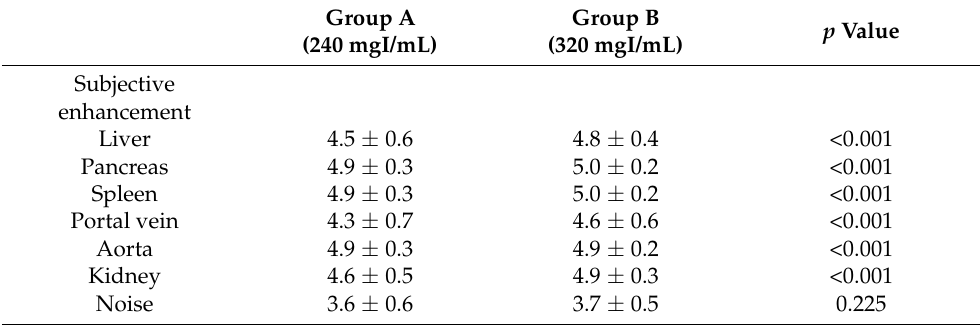
Table 4. Qualitative analysis in both groups according to the concentration of contrast